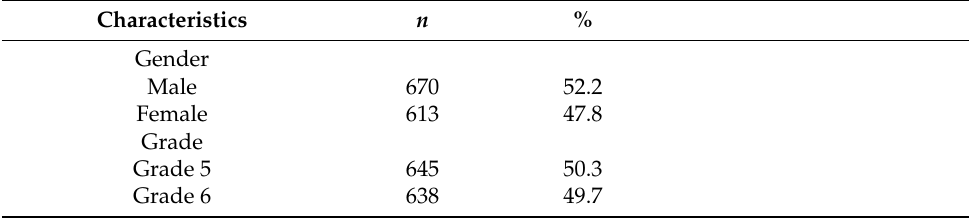
Table 1. Participant characteristics and reliabilities of